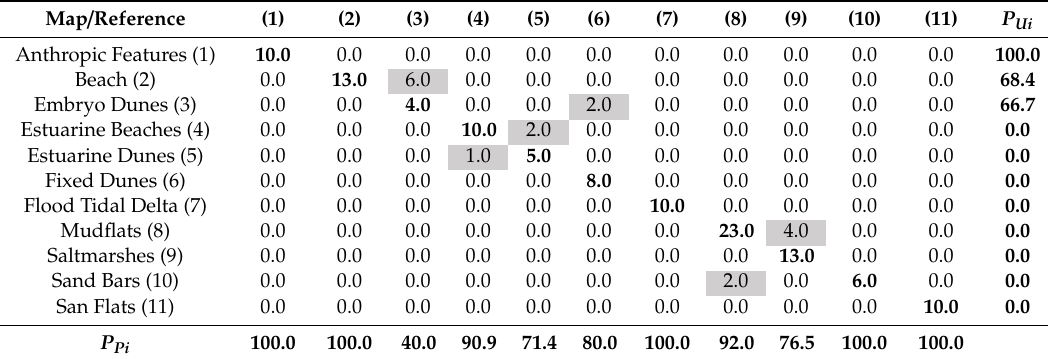
Table 2. Confusion matrix resulting from classifying training set pixels in the San Vicente de la Barquera estuary. Shaded cells indicate areas with larger confusion coe ffi cients between defined features. Main diagonal, in bold, indicates features confirmed by field inspection (reference points). Final column and row, in bold, show P Ui and P Pi for the corresponding feature. Column numbers match with row